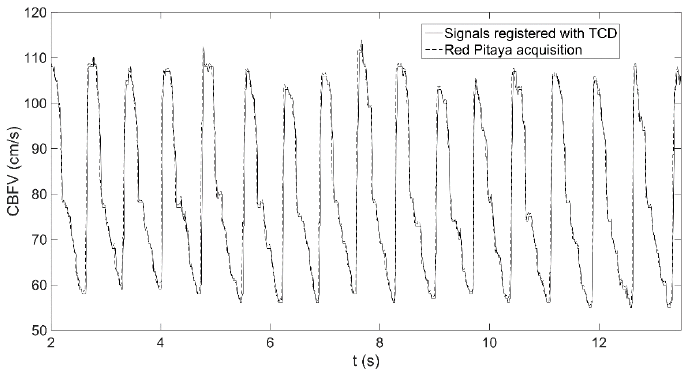
Figure 5. Representation of a fragment of the CBFV signal (cm/s) in the l left anterior cerebral artery (L-ACA) of a volunteer, as registered with the TCD ultrasound device (continuous line) and as acquired by the Red Pitaya (dashed line).